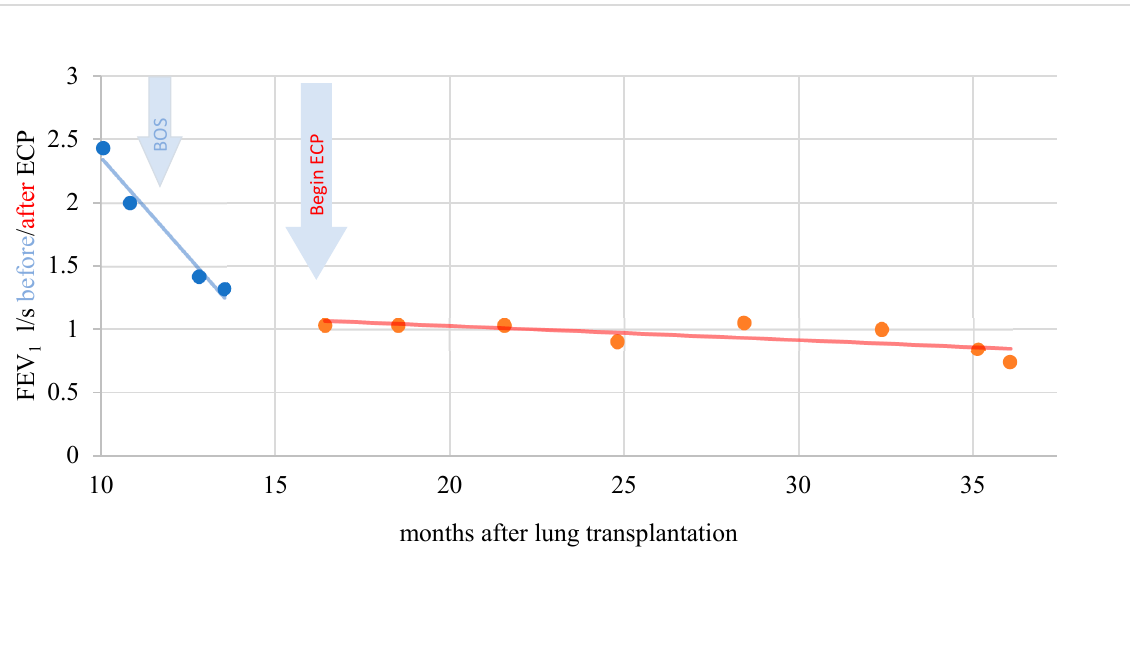
Figure 6. BOS patient without response and decreasing lung function during ECP. The patients' overall treatment responses depending on the BOS stage are shown in Table 4.